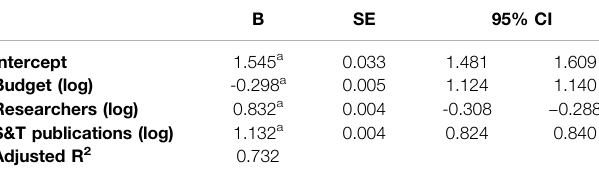
TABLE6| ModelofScienti fi cculturefactorsforthegeographiesofcitizenscience. The dependent variable is the number of contributions from each country. B SE